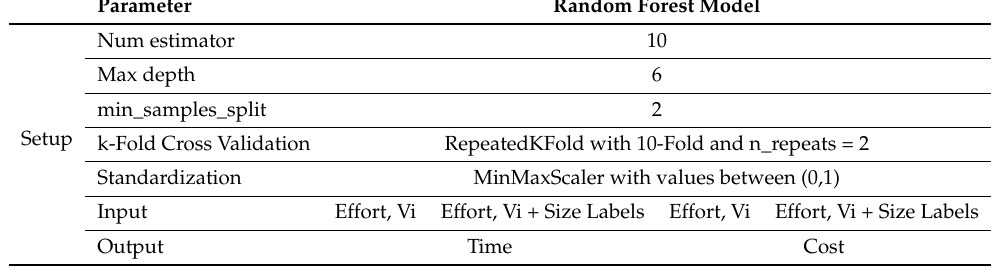
Table 3. Configuration for random forest algorithm.